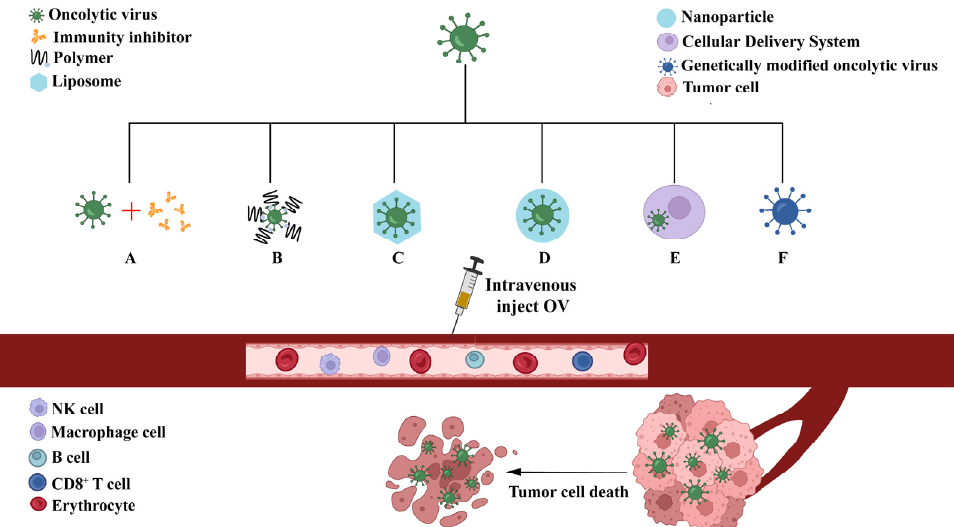
Figure 4. Strategies to overcome immune clearance and enhance targeting of tumors. These strategies can be applied to prevent the clearance of oncolytic virus (OV) by the body’s antiviral immunity and to improve the targeting of OV when systemic administration of intravenous OV is achieved for the treatment of tumors. ( A ): Combined with immune inhibitor. ( B ): Modification of OV using polymers. ( C ): Use of liposomes to encapsulate OV. ( D ): Use of nanoparticles to encapsulate OV. ( E ): Delivery of OV using cell delivery vectors. ( F ): Genetic editing of OV to improve targeting of tumors.